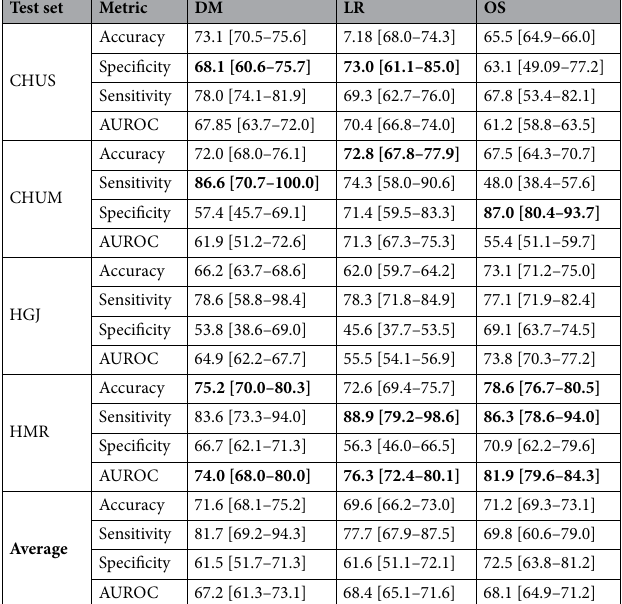
Table 4. Per-site 5-fold cross-validation. Figures reported are mean [95% confidence interval] for each of the 5 evaluated metrics. Each test set indicates that samples belonging to it were used for testing: the rest of the data was used for training and validation. Accuracy metric is normalized per class frequency. Bold corresponds to the highest value across Models for each Metric (Accuracy, Specificity, Sensitivity, AUROC) for each outcome (DM, LR,